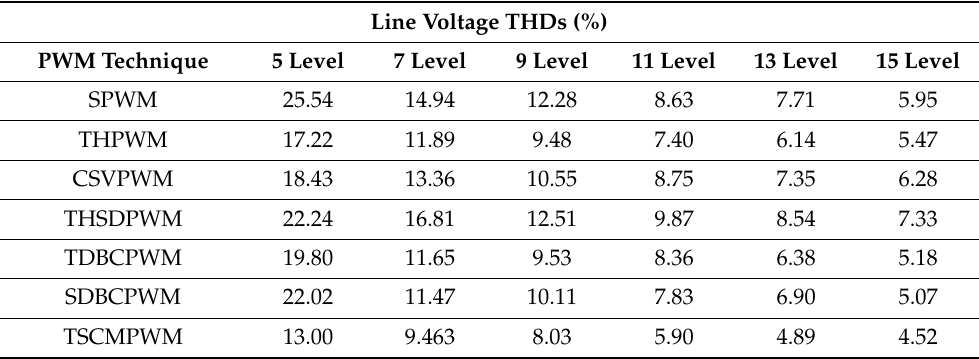
Table 5. Line voltage THDs of different PWM techniques for inverter level variation.